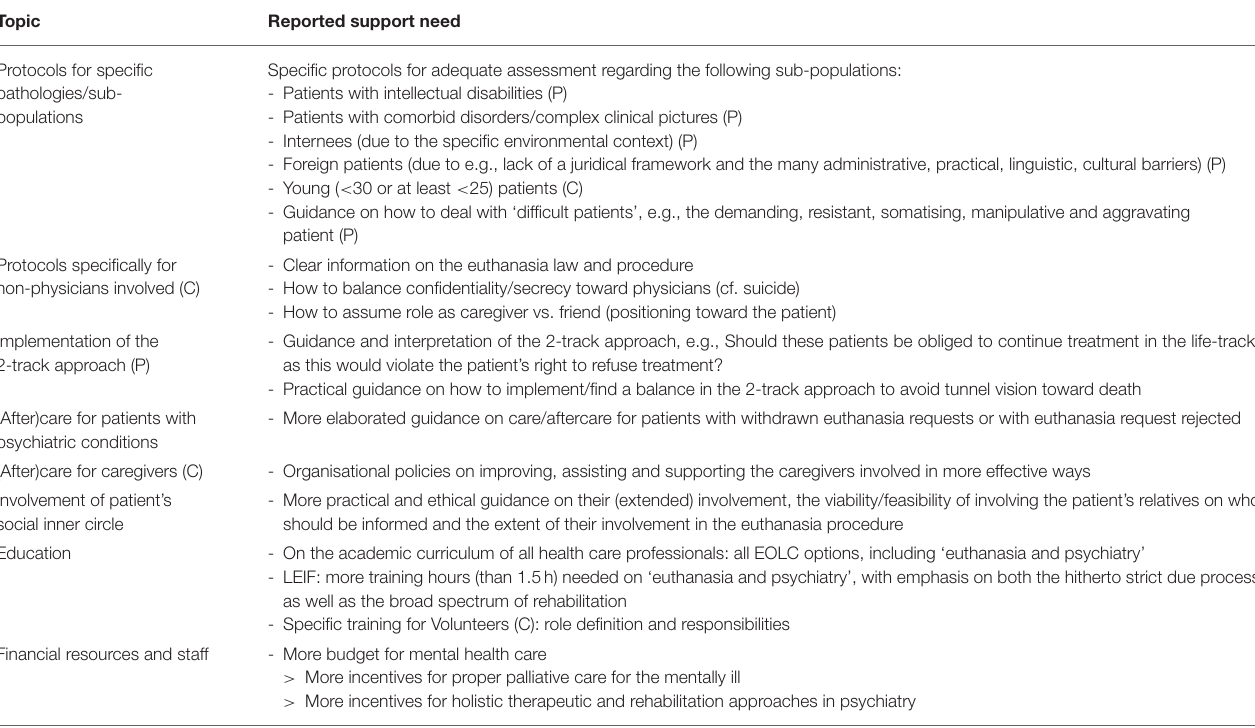
TABLE 3 | Support needs as voiced by healthcare professionals and volunteers regarding euthanasia in the psychiatric context a . Topic Reported support need Protocols for specific pathologies/sub-